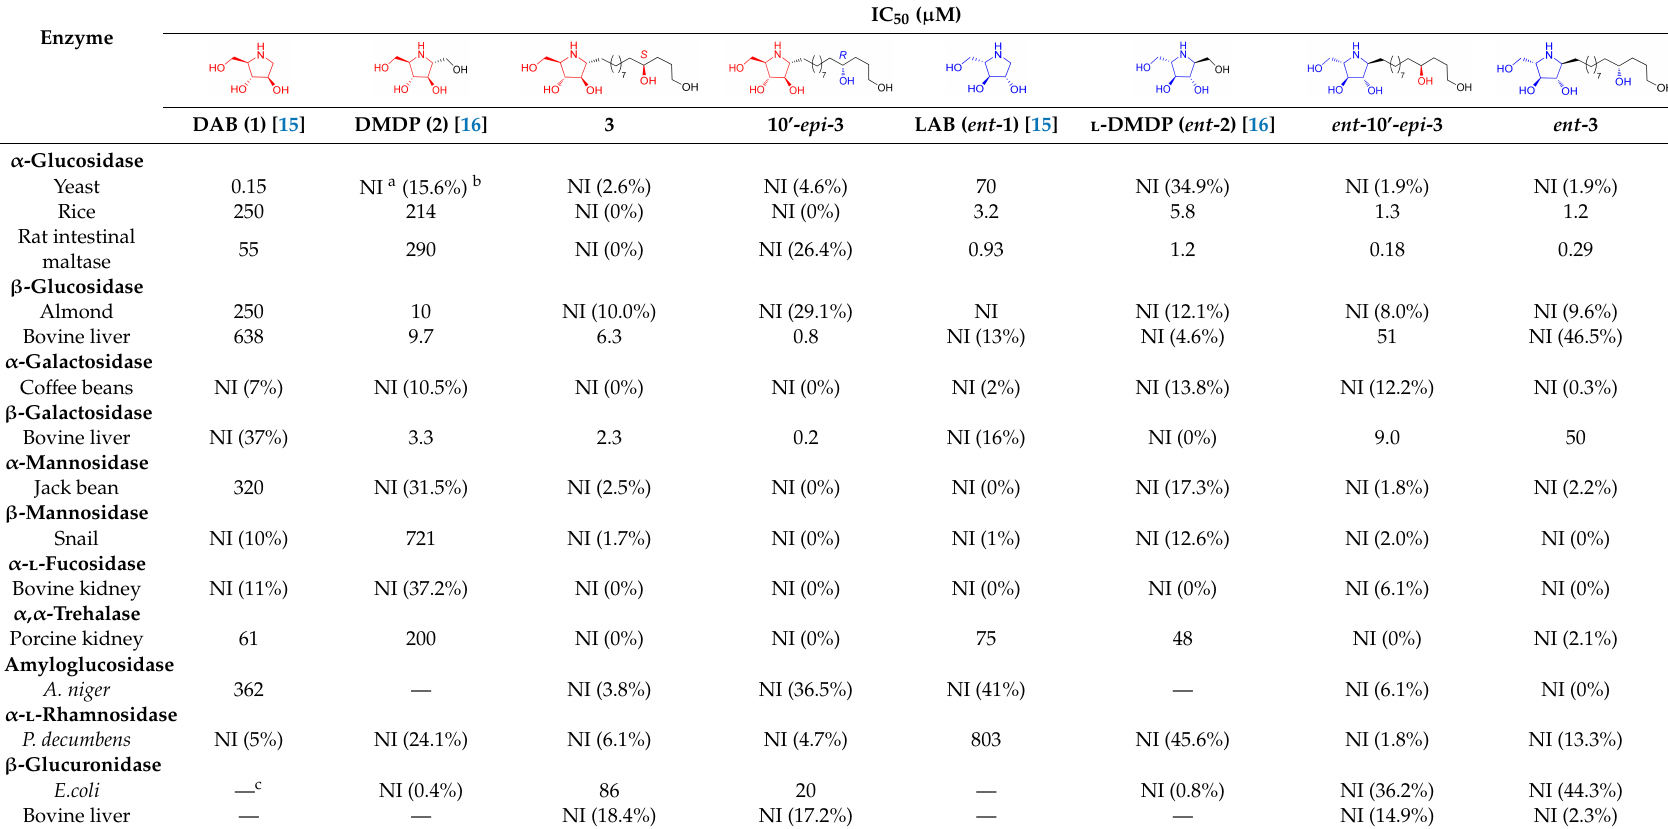
Table 2. Concentrations of Broussonetine M ( 3 ) and its DMDP-related analogs giving 50% inhibition of various